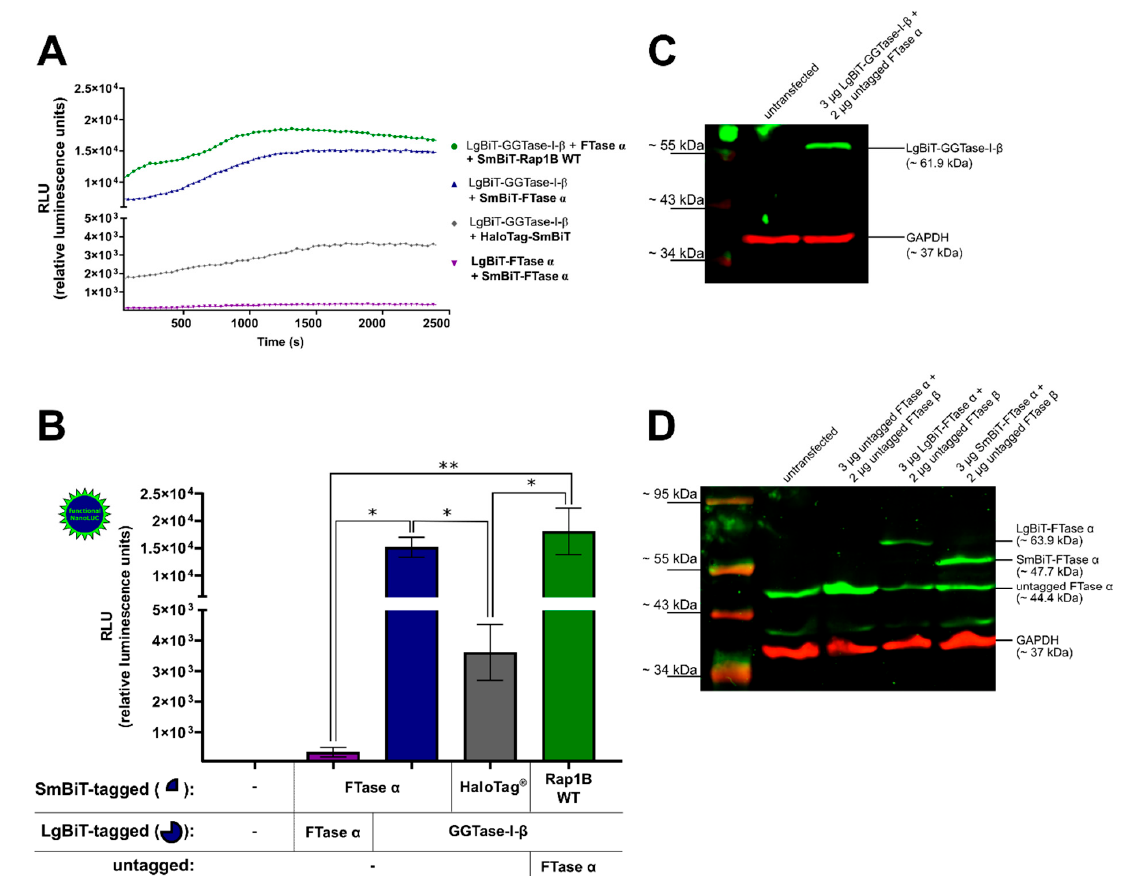
Figure 1. Development of a NanoBiT assay to measure the interaction of geranylgeranyltransferase type-I (GGTase-I) and Rap1B. Human embryonic kidney cells (HEK293) cells stably expressing the adenosine A 2B receptor (A 2B AR) were transiently co-transfected with combinations of plasmids encoding LgBiT or SmBiT attached to the N -terminus of farnesyltransferase (FTase) α , GGTase-I- β , and Rap1B wild-type (WT) (each 50 ng DNA/well). The untagged FTase α pcDNA3.1 ( − ) plasmid was co-transfected (100 ng DNA/well) in combination with LgBiT-GGTase-I- β to form the functional heteromeric enzyme, which was then able to interact with SmBiT-Rap1B WT. The co-transfected combinations LgBiT-FTase α /SmBiT-FTase α and LgBiT-GGTase-I- β /HaloTag ® -SmBiT (50 ng DNA/well) were used as negative controls, and the combination LgBiT-GGTase-I- β /SmBiT-FTase α served as a positive control. Additionally, for the Western blot analysis, the untagged FTase β pcDNA3.1 (+) was co-transfected in combination with untagged FTase α pcDNA3.1 ( − ), LgBiT-FTase α , and SmBiT-FTase α to form the functional heteromeric enzyme. ( A ) Real-time kinetic measurement of complex formation using the NanoBiT assay. Twenty-four hours after transfection, the NanoGlo live-cell substrate was added, and the association was immediately monitored at 25 ◦ C over a time period of 42 min with a luminescence reading taken every 30 s. ( B ) After a time period of ~ 900–1835 s, the maxima of complex formation were reached (dependent on which plasmid combinations were used, Figure 1A), and the relative luminescence units (RLU) were plotted. Significant differences for the combinations LgBiT-GGTase-I- β /SmBiT-FTase α and LgBiT-GGTase-I- β /FTase α /SmBiT-Rap1B WT over the negative controls LgBiT-FTase α /SmBiT-FTase α and LgBiT-GGTase-I- β /HaloTag ® -SmBiT were demonstrated (* p < 0.05, ** p < 0.01). ( C ) Representative Western blot analysis of LgBiT-GGTase-I- β expression in HEK293 cells stably expressing the A 2B AR. A specific monoclonal first NanoLuc/LgBiT antibody and an infrared second antibody were used to detect the NanoLuc fusion protein LgBiT-GGTase-I- β (green, ~ 61.9 kDa). A specific first monoclonal glycerinaldehyd-3-phosphat- dehydrogenase (GAPDH) antibody and infrared second antibody were used to detect GAPDH (red, ~ 37 kDa) as a loading control. Two independent Western blots were performed. ( D ) Representative Western blot of untagged FTase α , LgBiT-FTase α , and SmBiT-FTase α expression in HEK293 cells stably expressing the A α antibody and 2B AR. A specific first anti-FTase infrared second antibody were used to detect untagged FTase α (green, ~ 44.4 kDa), LgBiT-FTase α (green, ~ 63.9 kDa), and SmBiT-FTase α (green, ~ 47.7 kDa). The GAPDH antibodies were used as described above. Two independent Western blots were